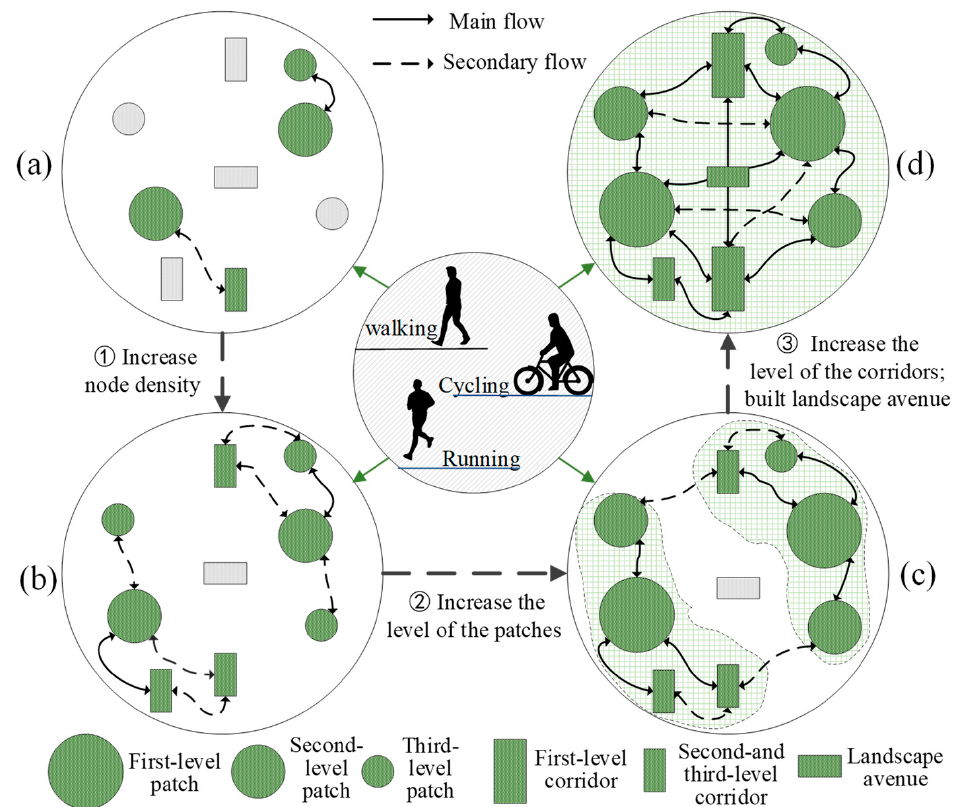
Figure 10. Optimization of the urban green space network based on the flow of green exercise (grey represents future green spaces, green represents built spaces). ( a ) Sparse connections between nodes; ( b ) Increased connections between first-level patches and their surrounding nodes; ( c ) Formation of subnetworks; ( d ) Formation of total flow network.